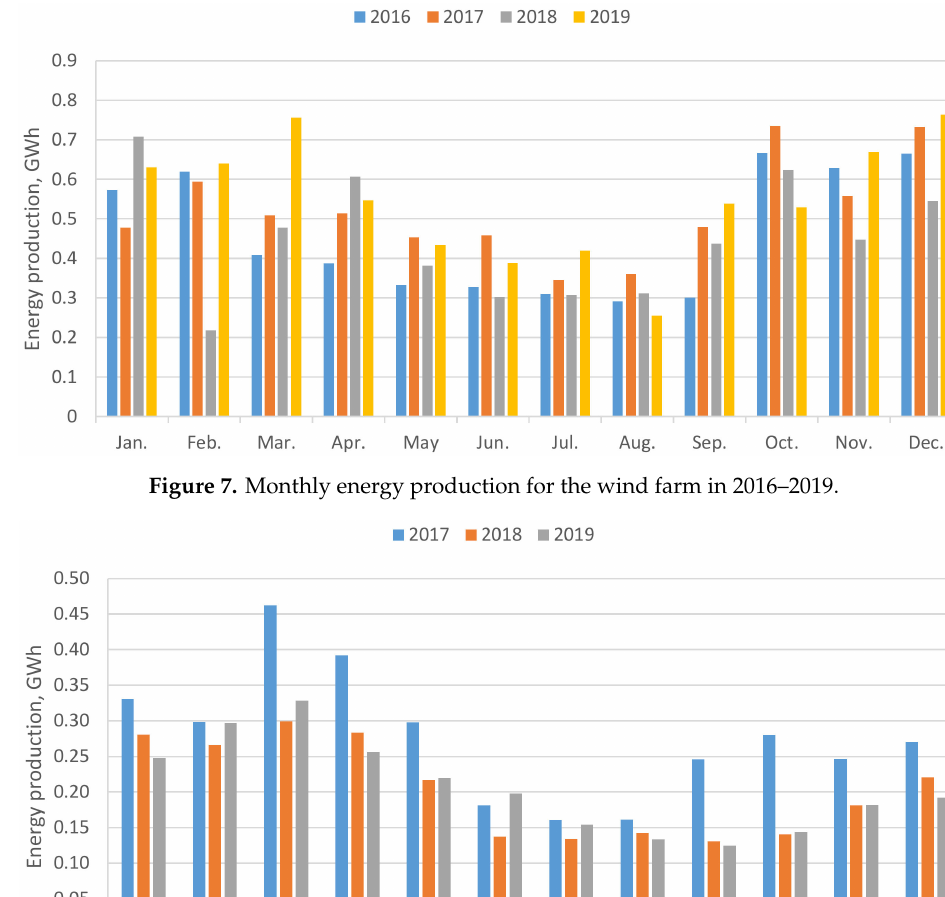
Figure 6. Monthly energy production for the photovoltaic power station in 2016–2019.